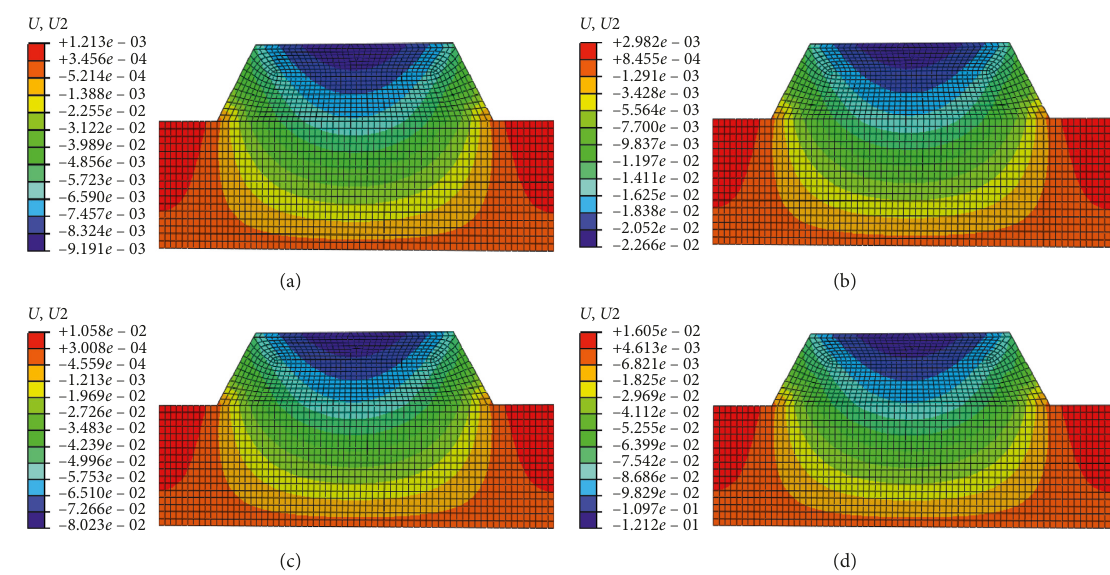
Figure 8: The postconstruction settlement of the uncompacted embankment (unit: m). (a) Settlement at the completion of filling. (b) Settlement after 1year of operation. (c) Settlement after 5years of operation. (d) Settlement after 10years of